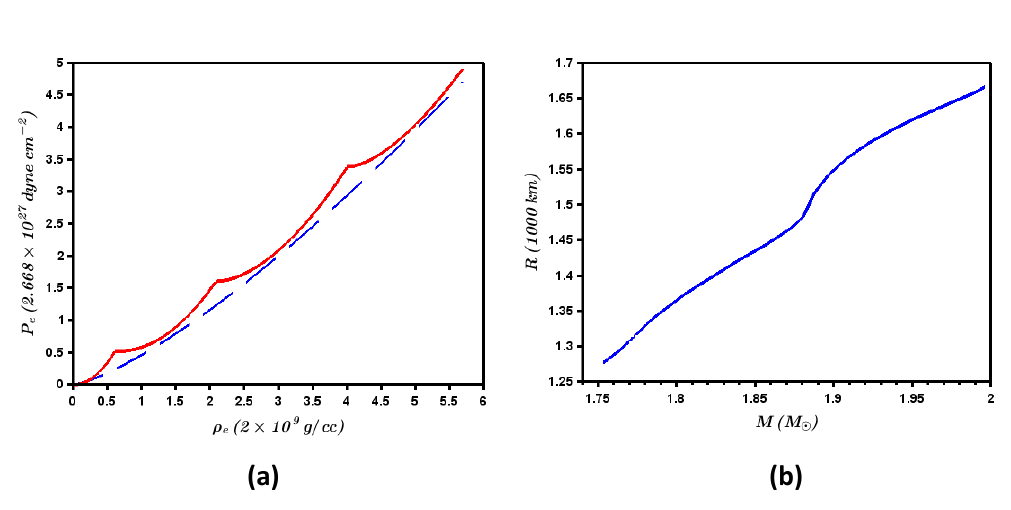
= 2 × 10 15 G (red solid cent = 18, (b) corresponding mass– Fmax